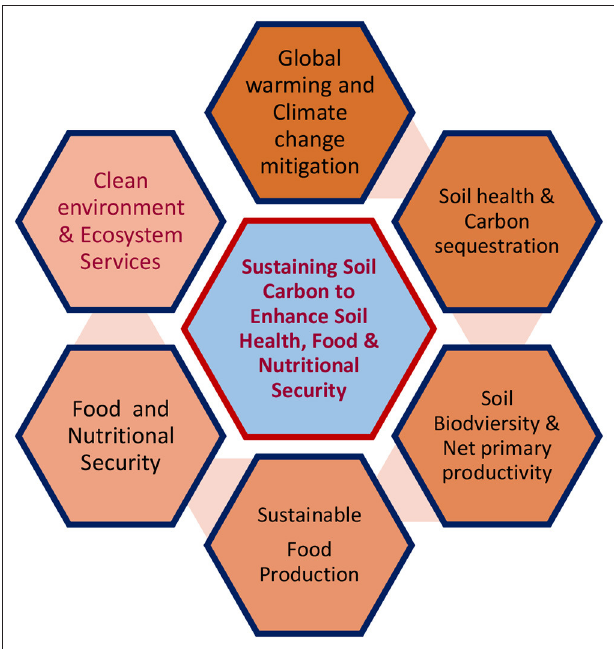
FIGURE 1 | Thematic concepts of different papers published in this Research